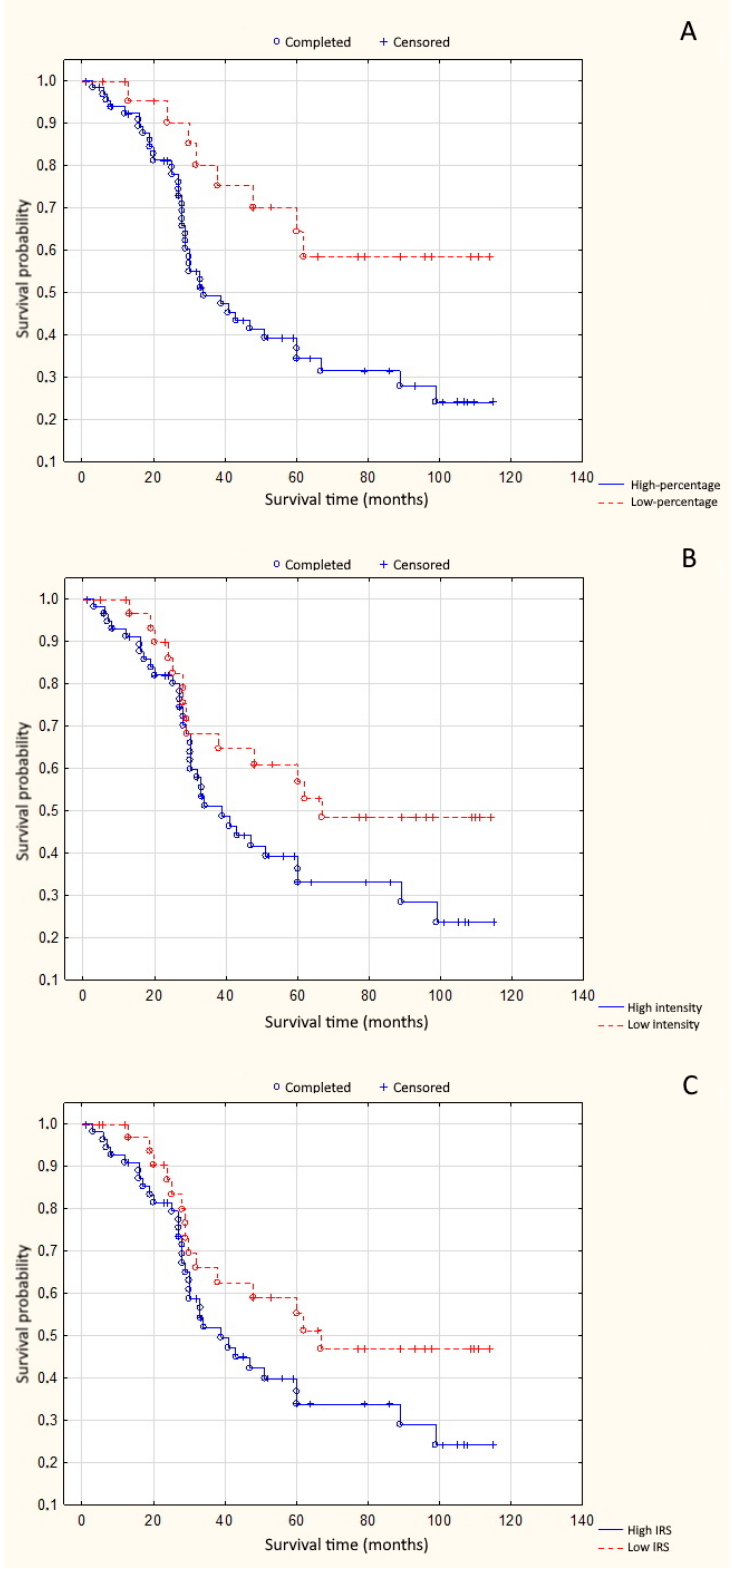
Figure 2. ( A ) Correlation between PARP-1 percentage of positive cells and overall survival time ( p = 0.008); ( B ) correlation between PARP-1 reaction intensity and overall survival time ( p = 0.072); and ( C ) correlation between PARP-1 total expression and overall survival time ( p = 0.089).